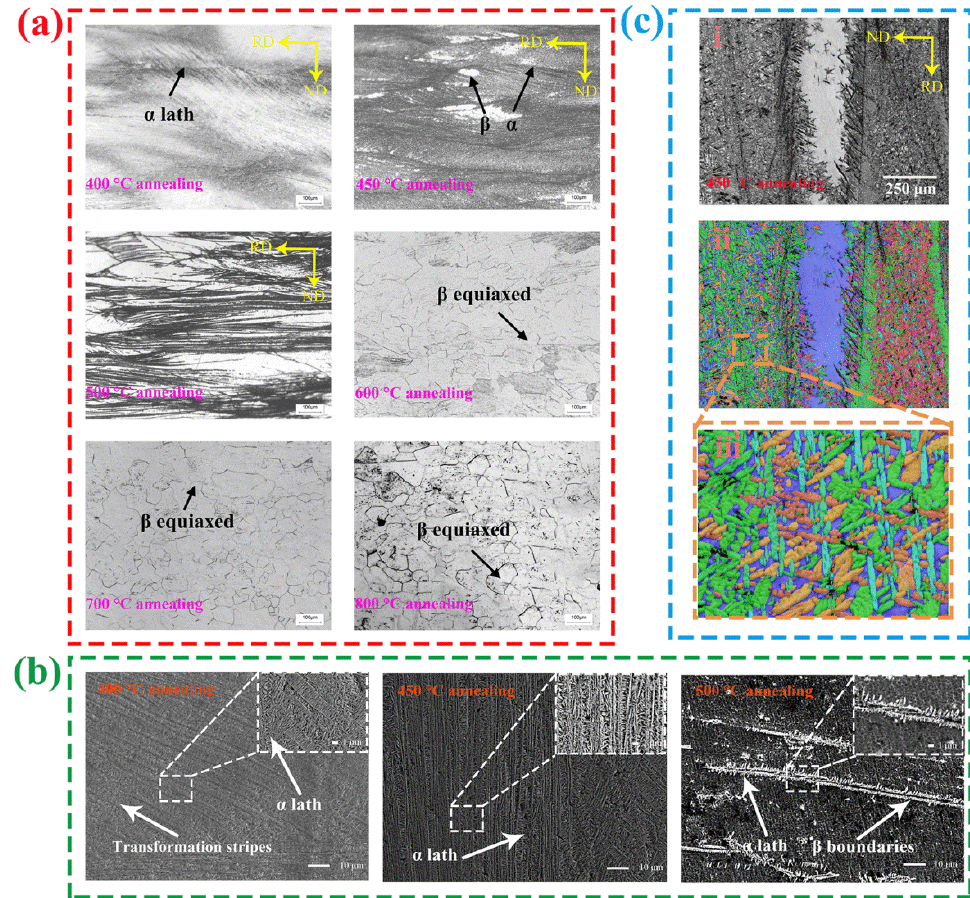
Figure 3. Microstructure of Zr – Ti – 8V alloy in annealed condition: ( a ) OM, ( b ) SEM, ( c ) EBSD.